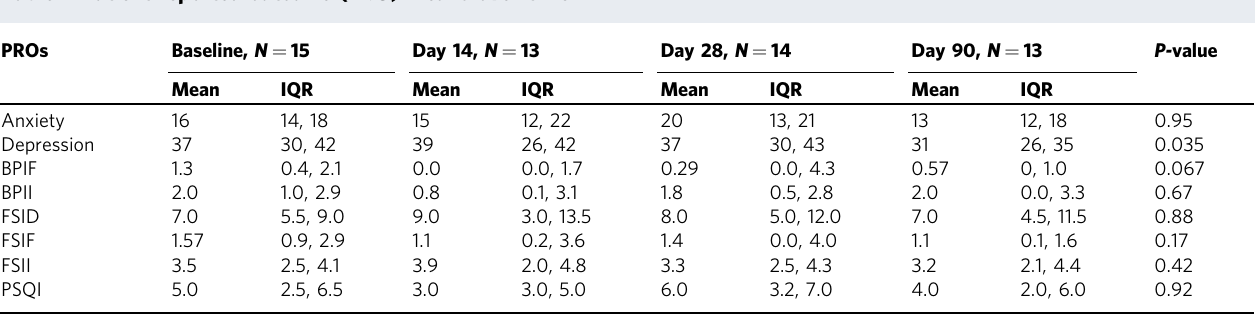
Table 2 Patient-reported outcome (PRO) means over time a .